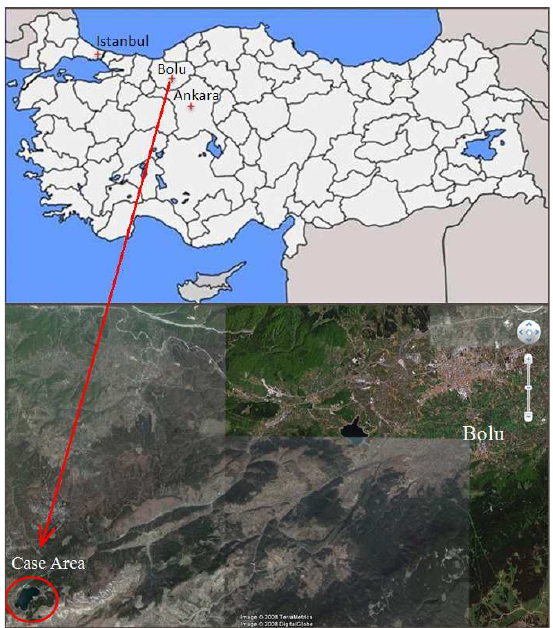
Figure 1. Geographical position of case area.